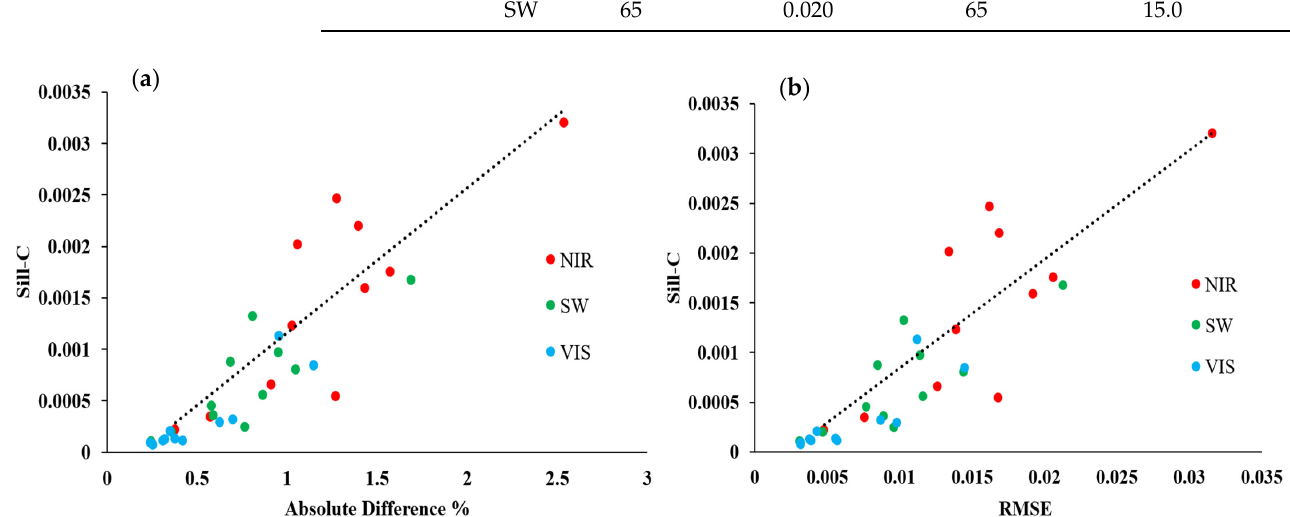
Figure 15. The Relationship of sill values with albedo differences(a) and albedo RMSE(b).